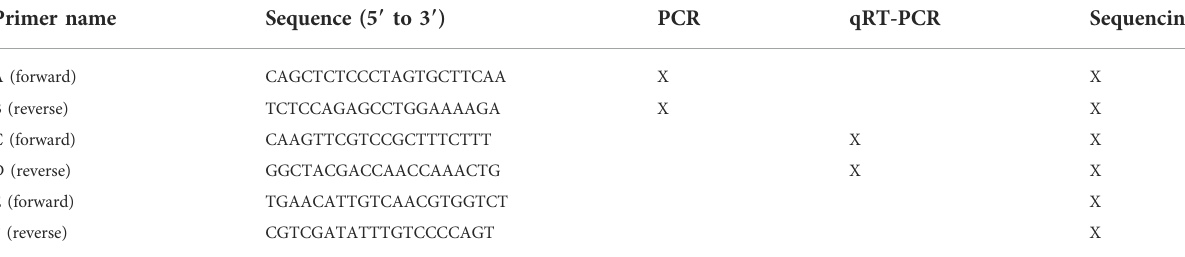
(Table 1). Reactions were run on a 7500 Fast Real Time PCR System (Applied Biosystems, Foster City, CA, United States) with an annealing temperature of 60 ° C for primers C and D. qRT-PCR data were expressed as Ct obtained for P2Y 4 mRNA in clonal